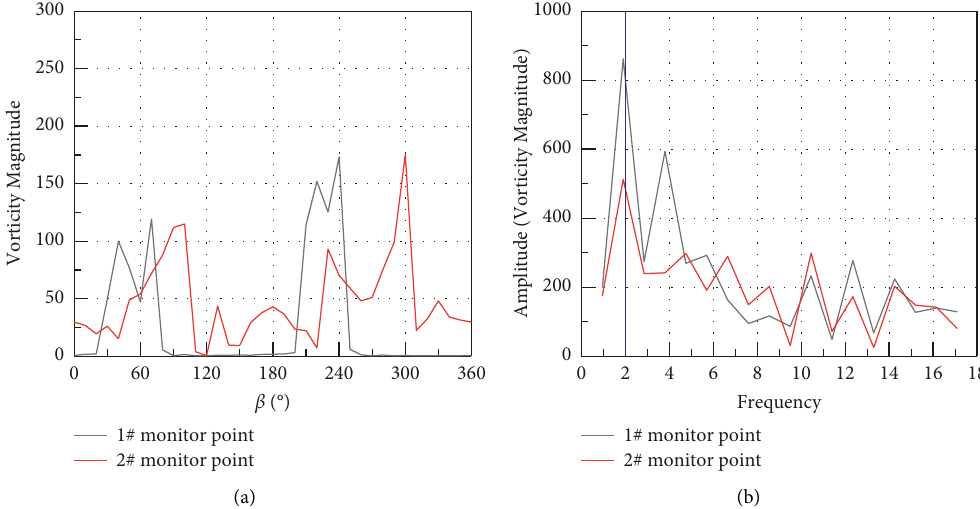
Figure 10: The vorticity distribution around the antenna changes with respect to the azimuth angle (AR � 2.5 and K � 0.2): (a) vorticity magnitude and (b) fast Fourier